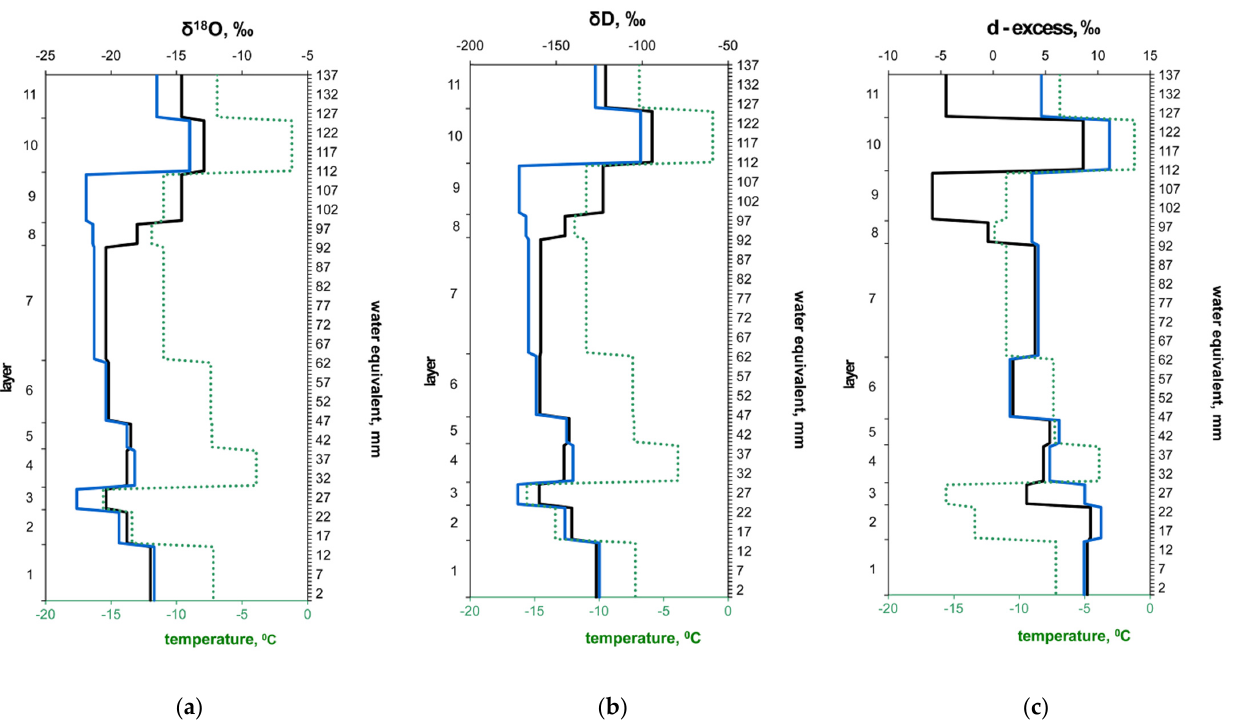
Figure 2. Comparison of changes in the isotopic composition ( δ 18 O ( a ), δ D ( b ), d-excess ( c )) in isolated layers of snow in the barrel (black), according to experiment No. 1 (see Section 2.2), with the precipitation-weighted mean values of the isotopic composition of the event-based snowfalls (blue) and the mean of the daily average air temperature (green dot line) calculated for the same period of winter 2019–2020.